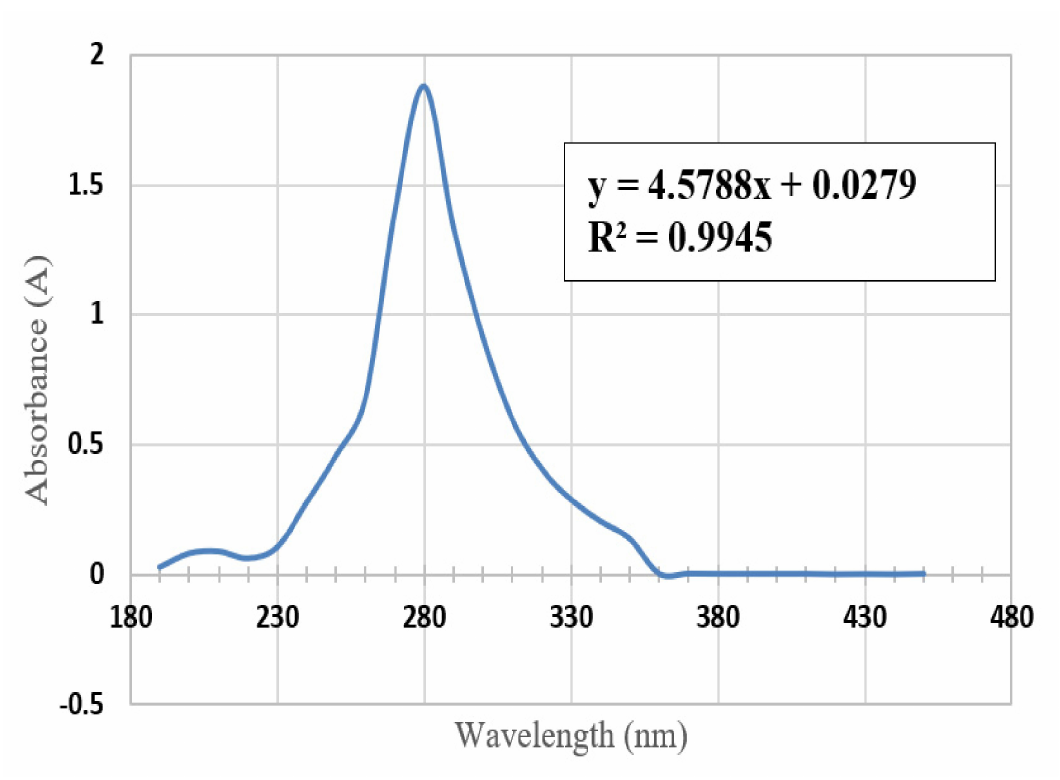
Figure 4. The absorbance peak of diluted nerolidol.